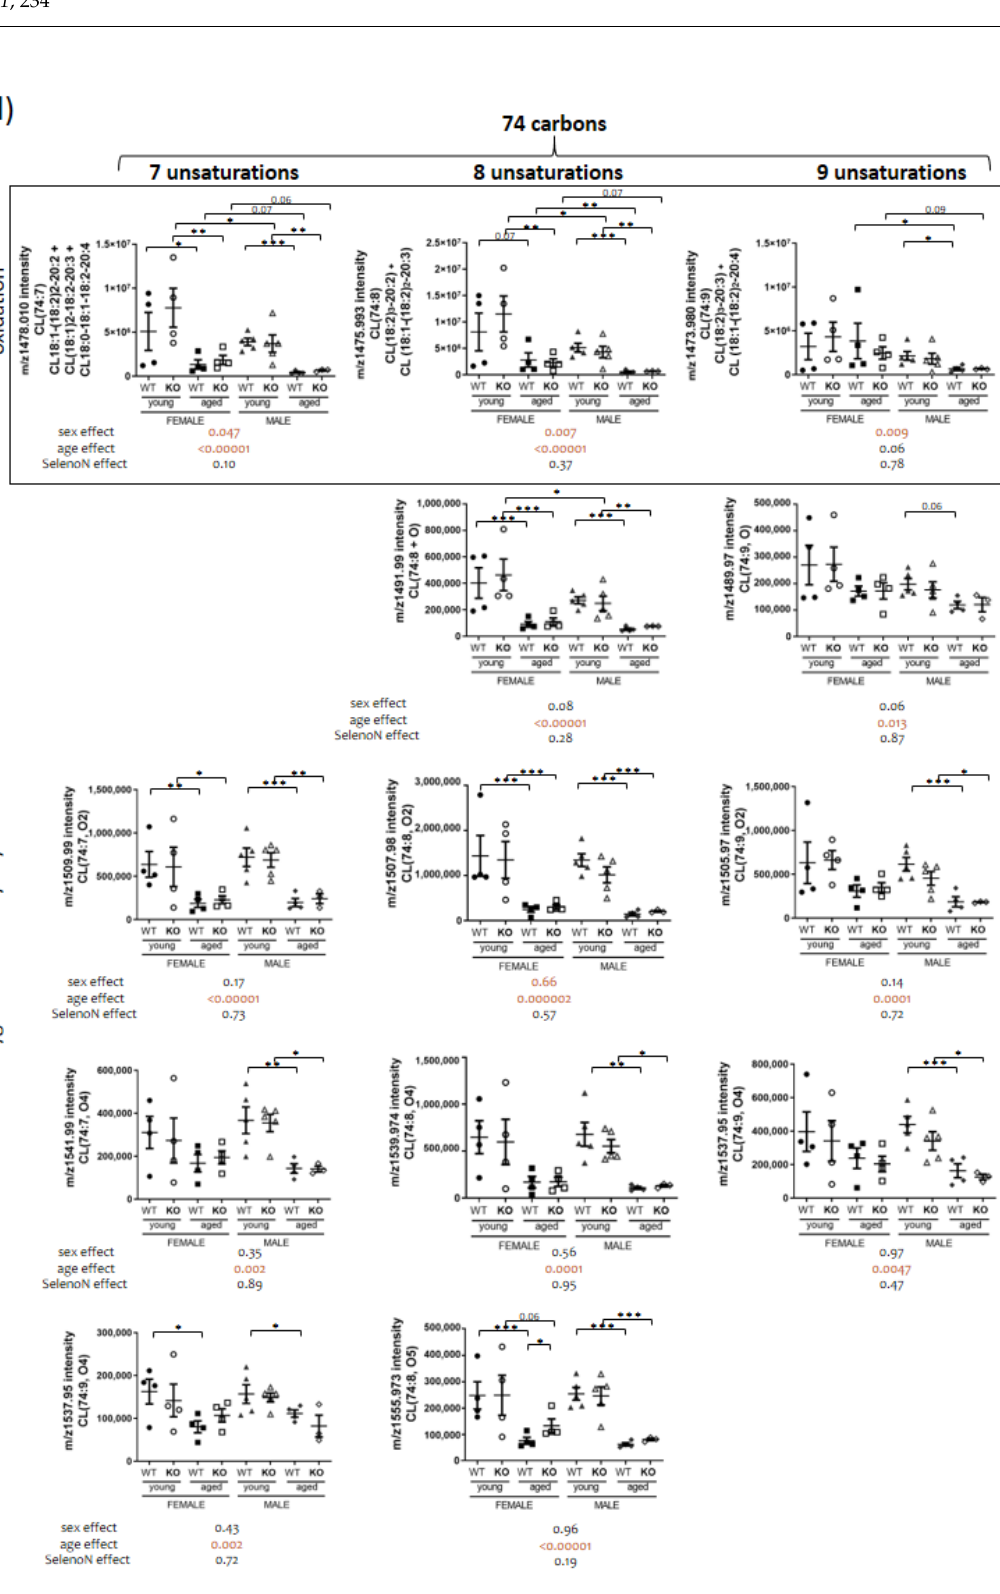
Figure 6. Cardiolipin remodeling in a sex, age and/or SelenoN KO context. ( a ) Analysis of m / z intensity of CL species with combined sex, age and SelenoN effects (mean ± SEM; n = 4 for each group, except young male WT and KO with n = 5 and aged male KO with n = 3). ( b ) Analysis of m / z intensity of CL species with sex, age or SelenoN significant differences. ( c ) Analysis of m / z intensity of CL containing 70 or 72 carbons. ( d ) Analysis of m / z intensity of CL containing 74 carbons. In the graph, p -value are from Tukey’s post hoc tests between pairwise groups. Under the graph, p -values for sex, age and SelenoN effect are defined in Table 2. * p < 0.05, ** p < 0.01 and *** p <